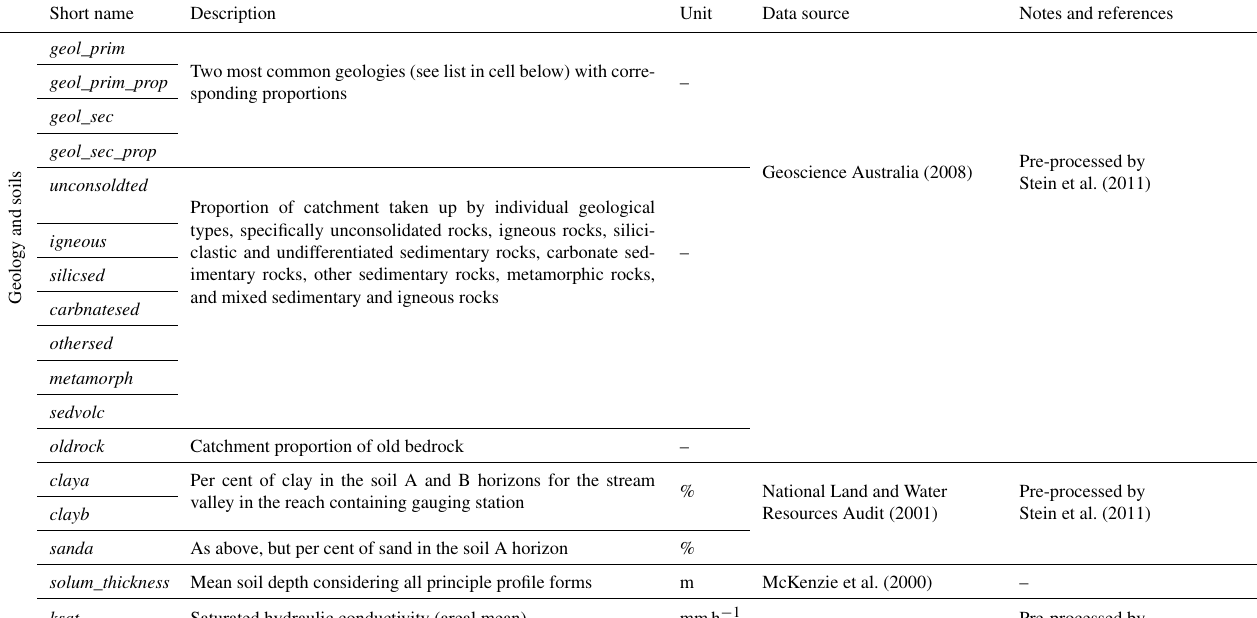
Table 4. Catchment attributes included in the attributes table of CAMELS-AUS (apart from climatic and hydrologic